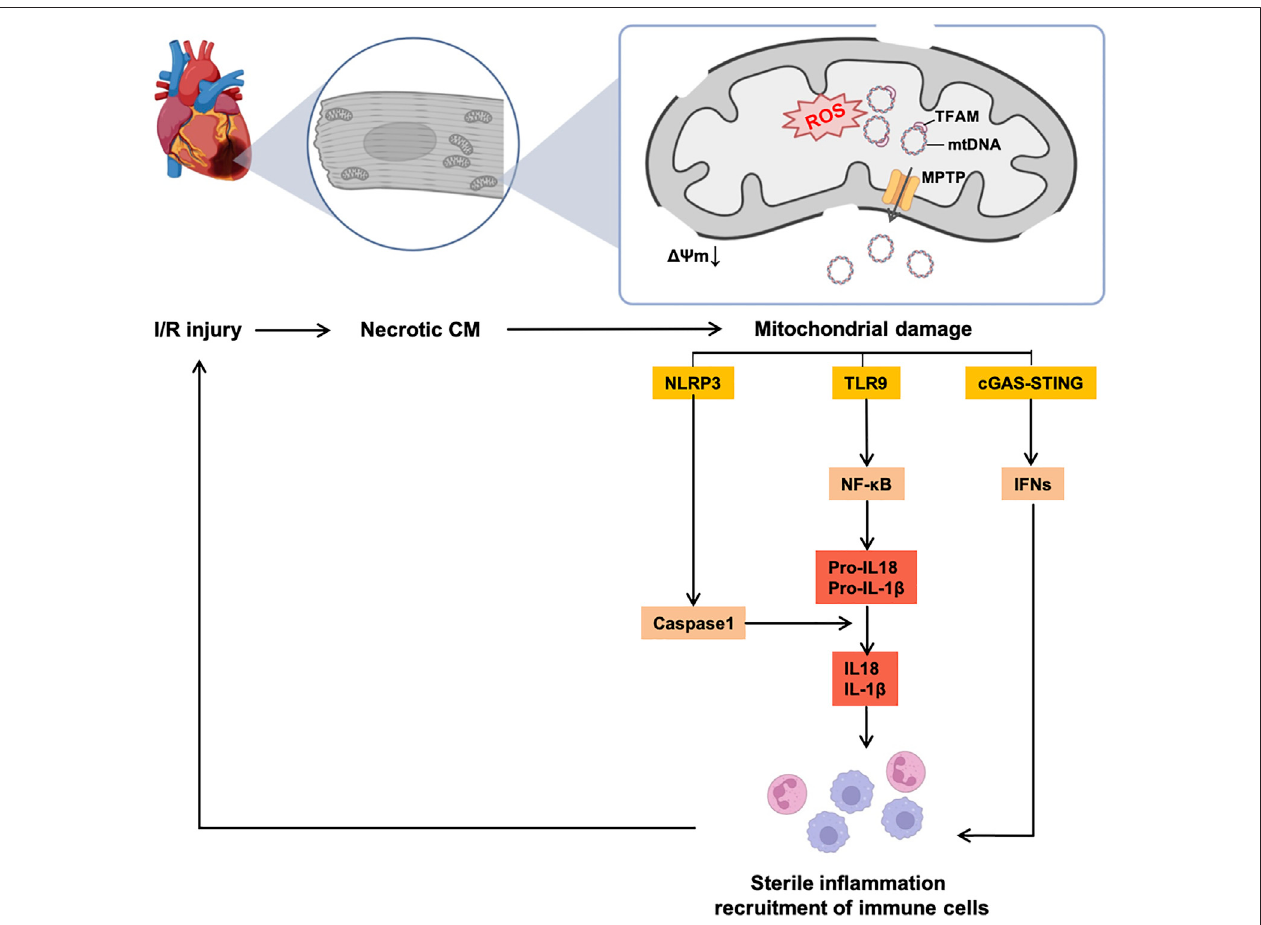
FIGURE 2 | Vicious circle of mtDNA-induced sterile in fl ammation and mitochondrial dysfunction in the I/R heart. Accumulation of mutant mtDNAs caused by excessive ROS release from MPTP, thereby inducing consecutive sterile in fl ammatory responses and recruitment of immune cells, which continuously aggregate I/R injury and CM necrosis. Abbreviations: I/R, ischemia/reperfusion, CM, cardiomyocyte, NLRP3, nod-like receptor pyrin domain containing 3, TLR9, toll-like receptor 9, cGAS, cyclic GMP – AMP synthetase, STING, stimulator of interferon gene, NF- κ B, nuclear factor kappa B, IFN, interferon, IL, interleukin.